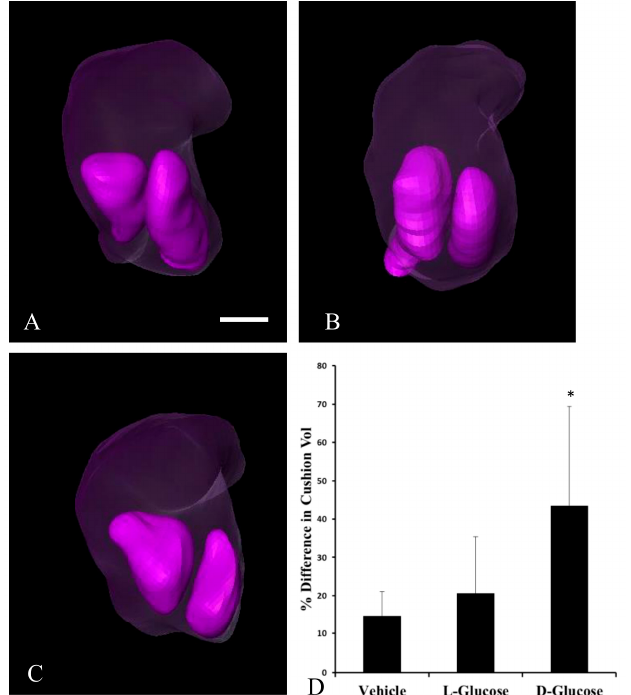
Figure 3. Segmented HH24 OFTs indicate endocardial OFT cushion asymmetry in response to hyperglycemia. Representative, reconstructed microcomputed tomography (Micro-CT) images of the OFT (transparent purple) with the cushions, left inferior, right superior, (purple) identified for a vehicle control ( A ), an osmotic control ( B ), and a D -glucose-treated embryo ( C ). ( D ) Average percentage difference in OFT cushion volume. Scale bar = 100 µm, equivalent across images. * p < 0.05 ANOVA.